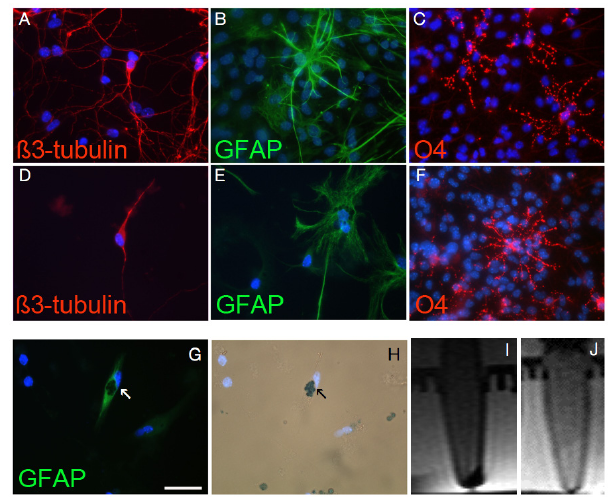
Figure 3. Differentiation capacity of FePro-labelled NPC. A – F . Immunocytochemistry of FePro ( A – C ) and Endorem ( D – F ) labelled neurospheres. A , D , anti- β 3-tubulin (neuron, red). B , E , anti-GFAP (astrocyte, green). C , F , anti-O4 (oligodendrocyte, red). Blue, Hoescht nuclear stain. FePro-labelled neurospheres can differentiate into neurons ( A , D ), astrocytes ( B , E ), and oligodendrocytes ( C , F ). G , immunocytochemistry of FePro-labelled astrocyte (GFAP, green). H , corresponding light micrograph showing Prussian blue stain. I , J MRI T -weighted image of FePro-labelled neurosphere pellet ( I ) and 2 control unlabelled cell pellet ( J ). FePro-labelled cell pellets produce hypointensity on MRI images. Arrows denote a GFAP-labelled cell co-labelled with Prussian blue, indicating that the FePro-labelled cell was capable of astrocyte differentiation. Scale bars, 20